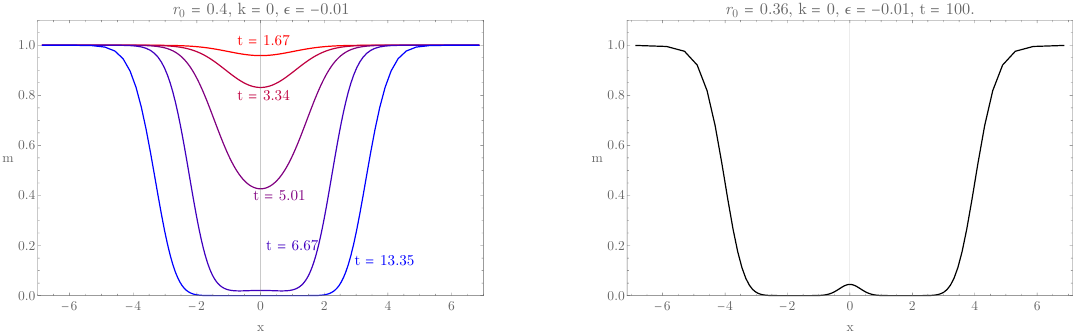
Figure 3 . Scenario 2. Left: pinch to a final static configuration with a finite ditch, corresponding to a twin black droplet. The difference with the evolution in figure 2 is the sign of the initial perturbation, which here pushes downwards. Right: formation of a small central transient black hole, which very slowly decreases in size. The initial string is thinner than in the previous case, and therefore contains more unstable modes.